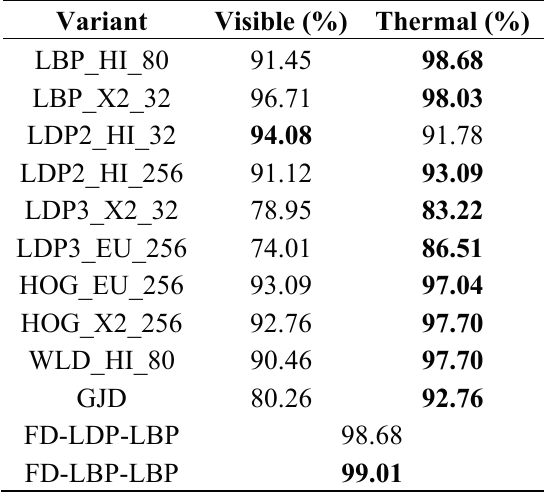
Table 3. Average recognition rate for the proposed fusion method against all face recognition methods for the PUCV-VTF database. Results in bold show the best